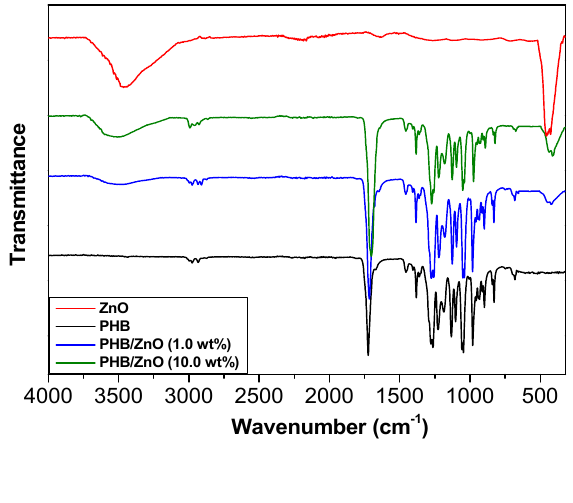
Figure 3. FT-IR spectra of ZnO, neat PHB and the nanocomposites with 1.0 and 10.0 wt % nanoparticle